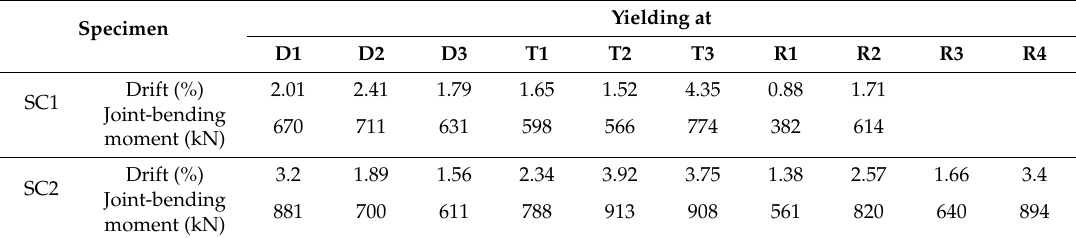
Table 3. Joint-bending moments and the corresponding drift at several yielding points.